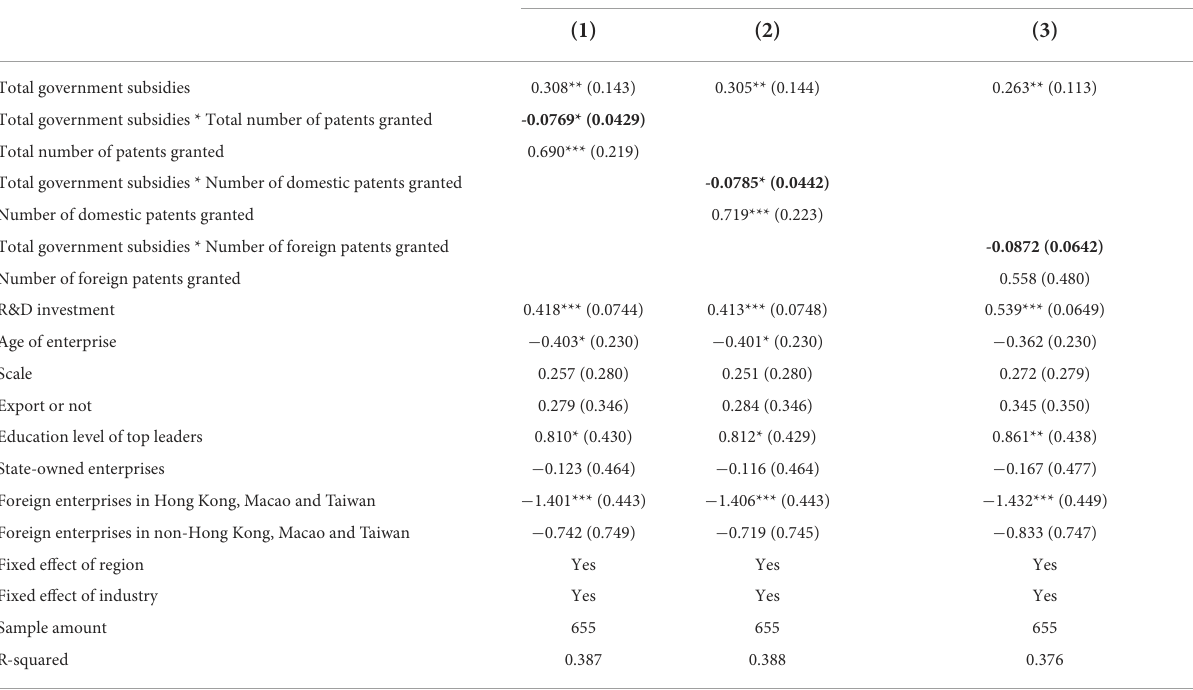
TABLE 3 Government subsidies and enterprise “independent